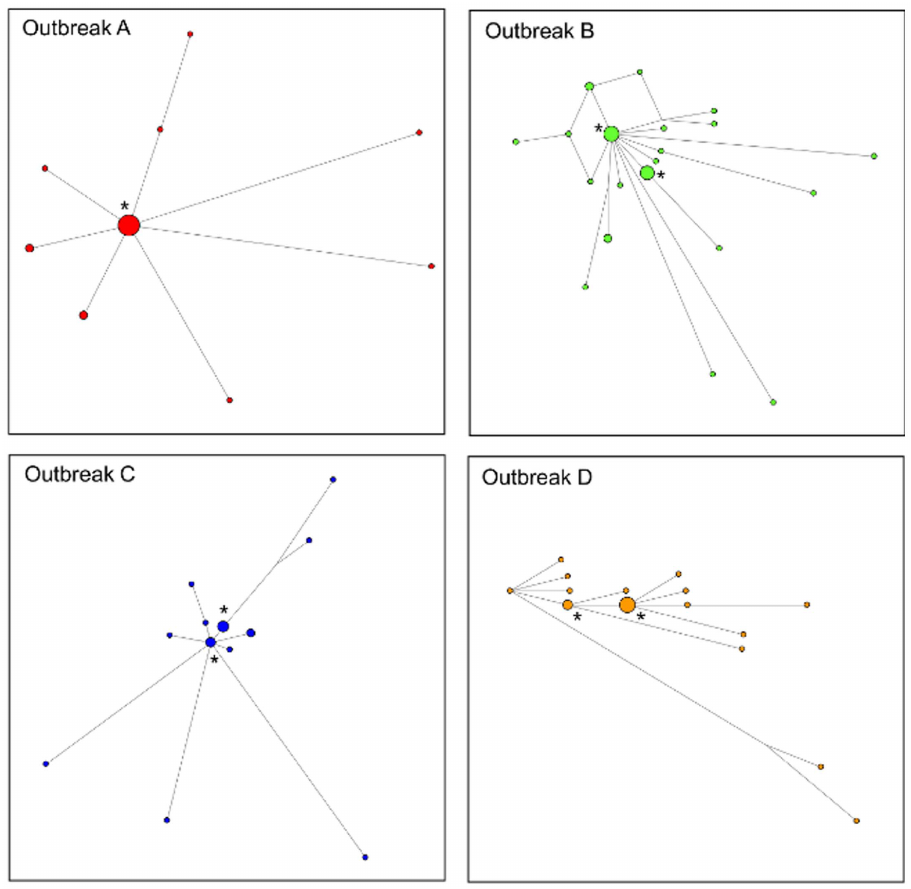
Figure 2. Median joining network analysis. Median Joining Networks constructed using WG sequences. Viral strains from each outbreak are color coded. Major HAV variants are denoted by ‘‘*’’.